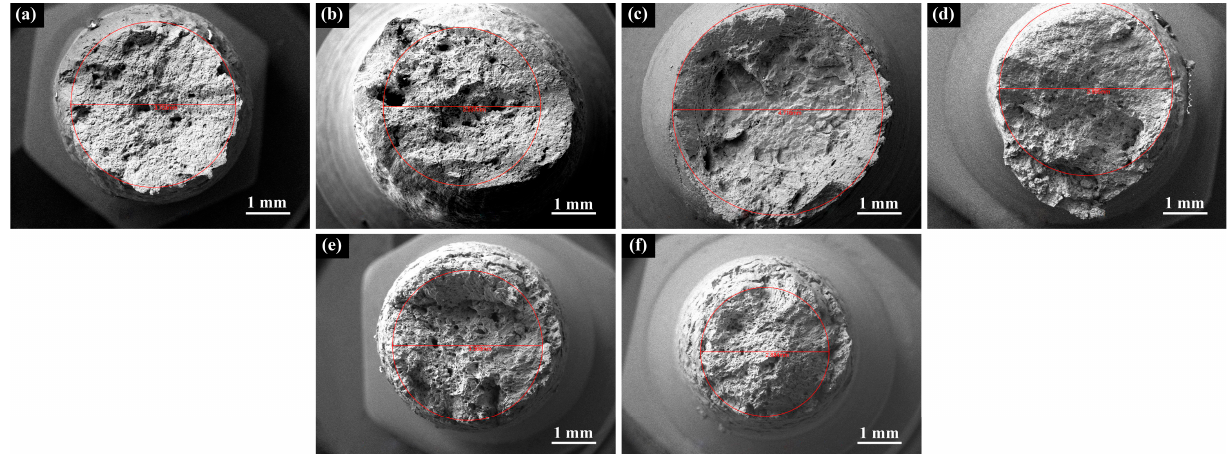
Figure 7. Fracture surface features obtained after hot testing: ( a , b ) boron-free (CP-B0) and boron- containing (CP-B60) steels tested at 700 ◦ C, ( c , d ) CP-B0 and CP-B60 steels tested at 800 ◦ C, and ( e , f ) CP-B0 and CP-B60 steels tested at 900 ◦